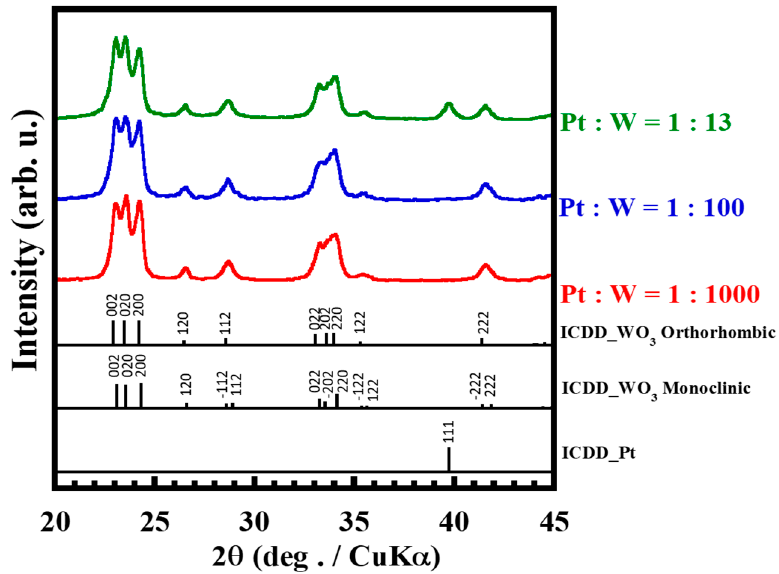
Figure 2. XRD spectra of Pt/WO 3 nanoparticles with different amounts of the Pt catalyst.